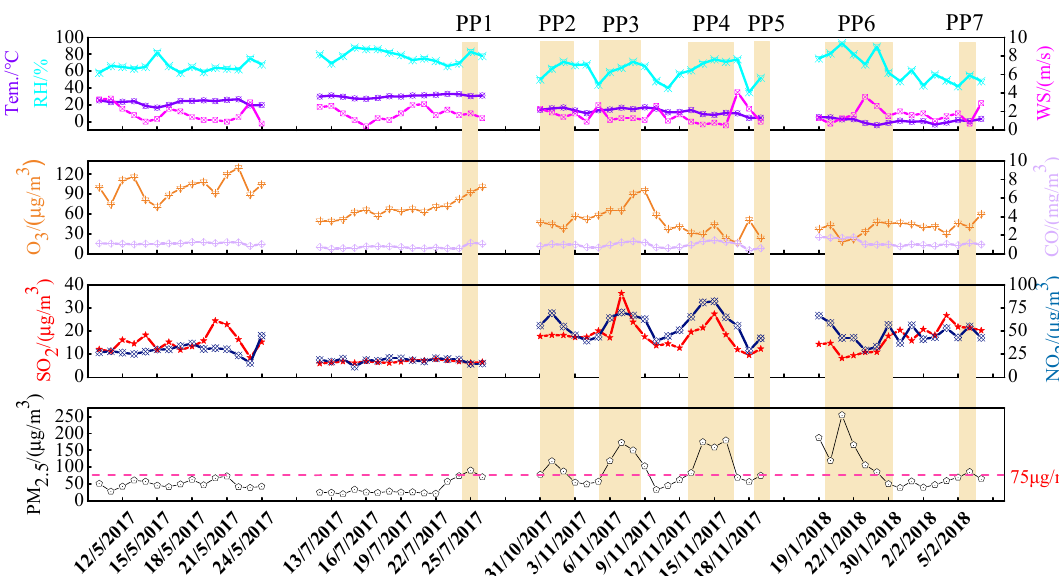
Figure 2. Variation in ambient PM 2.5 and gaseous pollutants as well as meteorological parameters during the study. The light brown bar represents the pollution period and is marked as PP1-PP7; 75 µg/m 3 is the Grade II limit for the PM 2.5 daily average stated by the Chinese National Ambient Air Quality Standard (GB 3096-2012). WS: wind speed; Tem.: temperature; RH: relative humidity. Table 1. Seasonal and annual average concentrations of PM 2.5 and of the major chemical species, as well as meteorological parameters and the concentrations of gaseous pollutants during the sampling period. Species Spring Summer Autumn